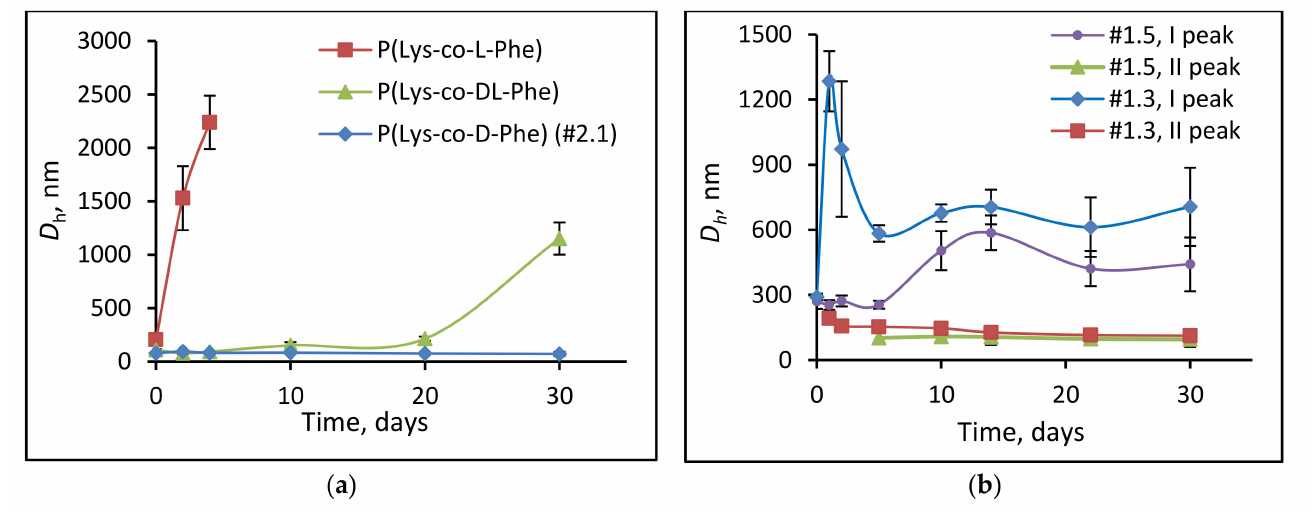
Figure 7. Changes in hydrodynamic diameters of NPs over time (DLS): ( a ) P(Lys- co -Phe) and ( b ) PMAG- b -P(Lys- co -Phe) NPs. Conditions of biodegradation: 0.01 M PBS, pH 7.4, T = 37 ◦ C, C NPs = 1.0 mg/mL; C papain = 0.5 mg/mL. The compositions of different polymer samples are pro- vided in Table